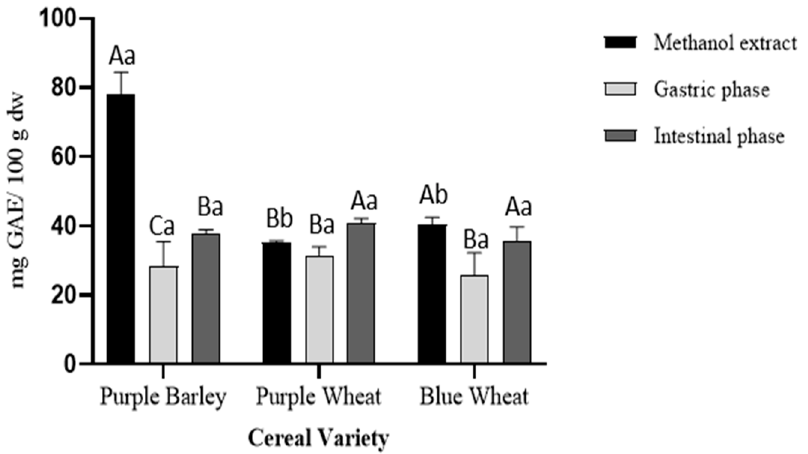
Figure 1. Total phenolic content of extracts from digestion of pigmented cereal flour compared with a methanol extract using a Folin–Ciocalteu method. Data shown is blank corrected, expressed as mg GAE/100 g dry weight cereal flour and represent mean ± SD; n = 3. Different capitalized alphabets represent significant differences within a cereal variety. Different lowercase alphabets represent significant differences between cereal varieties.